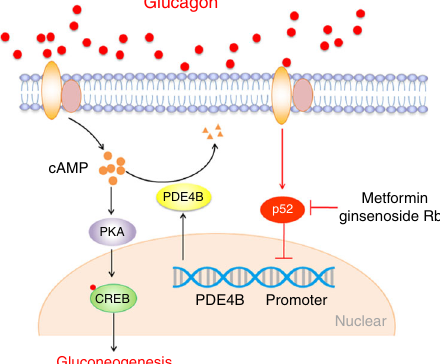
Fig. 6 NF- κ B2 (p52) activation restrains the hepatic glucagon response by preserving PDE4B induction. Glucagon induces p52 activation. Activated p52 binds to PDE4B promoter to inhibit its transcription, leading to cAMP accumulation. Accumulated cAMP augmented glucagon response by cAMP/PKA signaling. Metformin and ginsenoside Rb1 inhibited p52 activation to restrain hepatic glucagon response by preserving